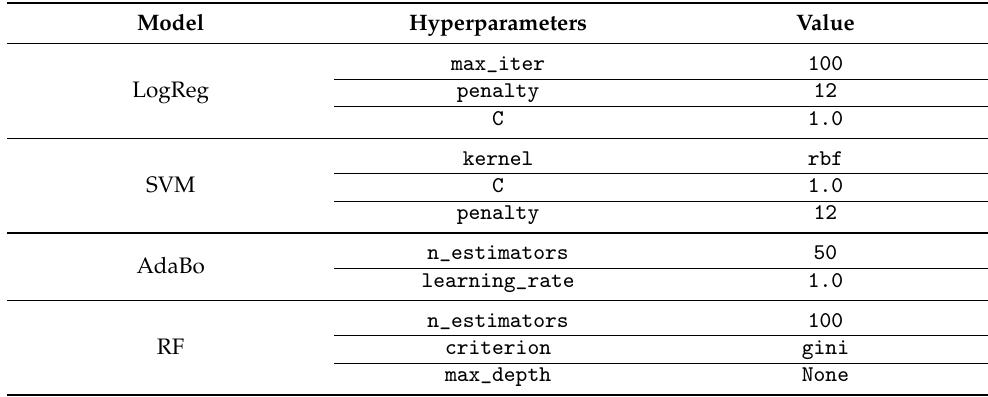
Figure 6. Experimental Setup. ( a ) Workflow for experiment 1. It consists of separate internal cross- validation for each cohort. ( b ) Workflow for experiment 2. It consists of using D1 for training and D2 and D3 as external validation cohorts. ( c ) Workflow for experiment 3. It consists of using D1 and D2 for training and D3 as external validation cohort. ( d ) Workflow for experiment 4. It consists of performing internal cross-validation considering D1, D2, and D3 as a single large cohort. Table 3. Training